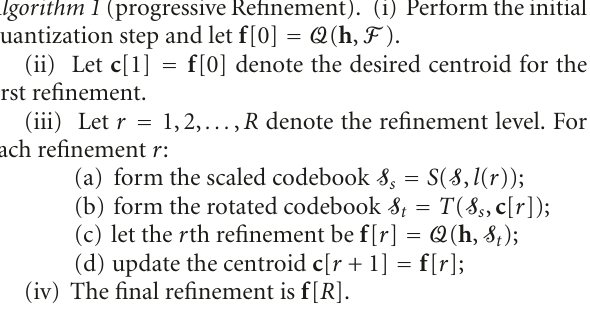
Algorithm 1 (progressive Refinement). (i) Perform the initial quantization step and let f [0] = Q ( h , F ).